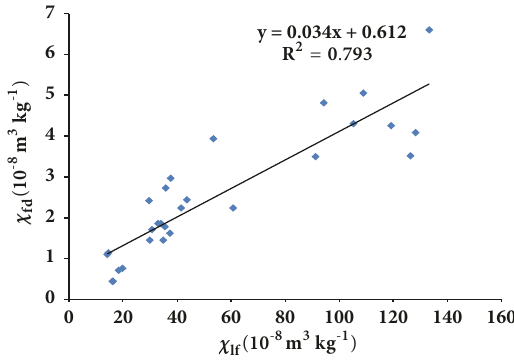
Figure 3: Interdependence between 𝜒 fd and 𝜒 lf for reforested land.